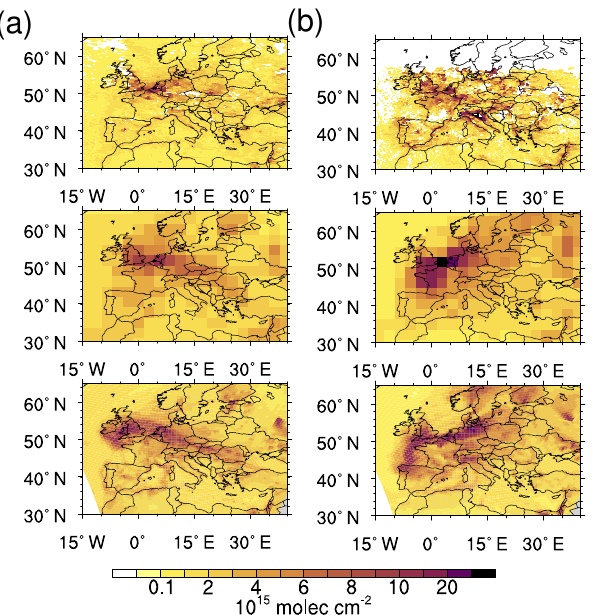
Figure 4. Tropospheric NO 2 columns (in 10 15 moleccm − 2 ) of SCIAMACHY (top), EMAC (middle) and CM50 (bottom) for (a) June and (b) December